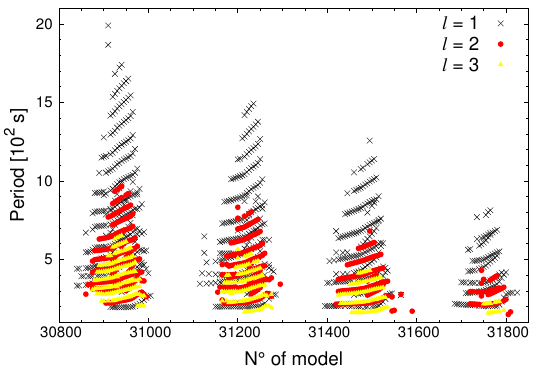
Figure 5. Period vs. number of model of sequences with Z = 0.02, Y = 0.4 and M * = 0.445 M , corresponding to ℓ = 1 (black crosses), ⊙ ℓ = 2 (red points) and ℓ = 3 (yellow